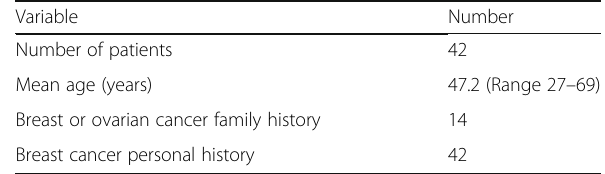
Table 1 Patients ’ demographics